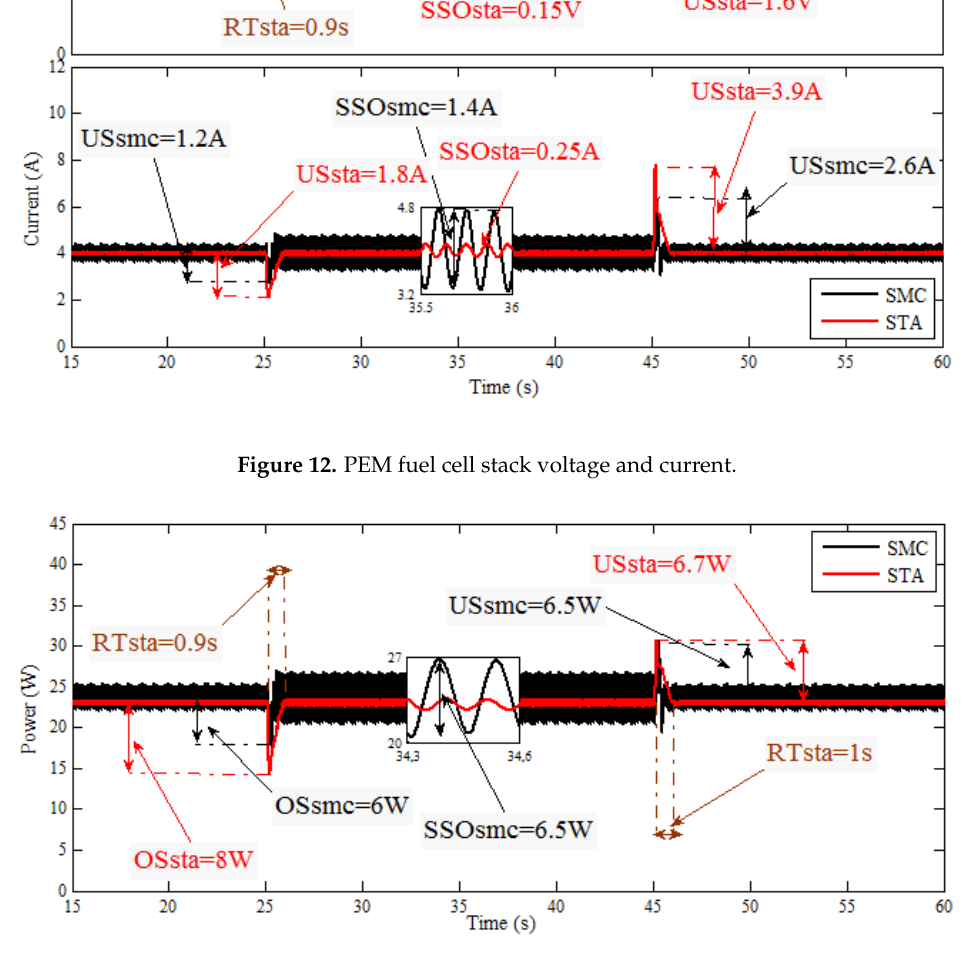
Figure 13. PEMFC stack